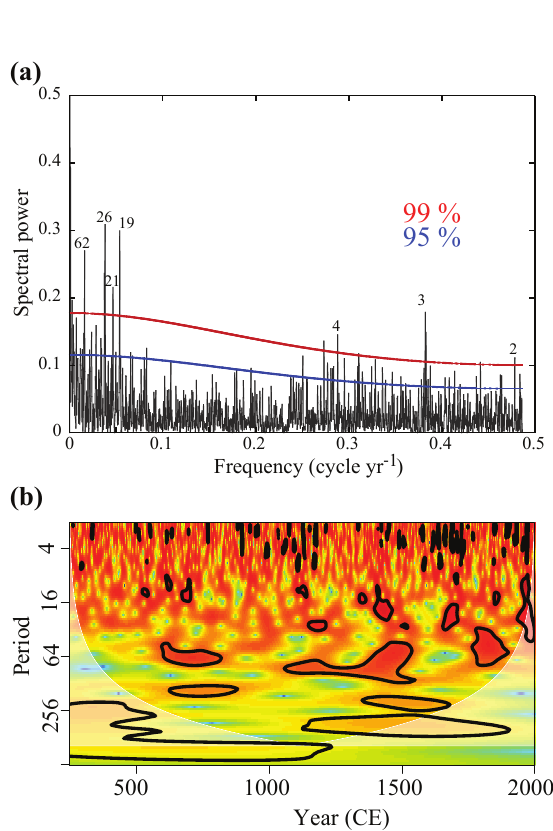
Figure 5. (a) Spectral analysis of the varve thickness series (Schulz and Mudelsee, 2002). (b) Wavelet analysis: black boundaries show the 95% confidence level based on a red noise process. White shad- ing represents the cone of influence where edge effects might be